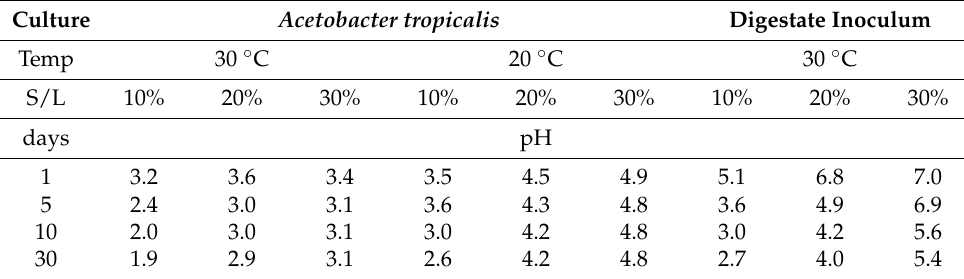
Table 2. Time-monitored pH values of different culture